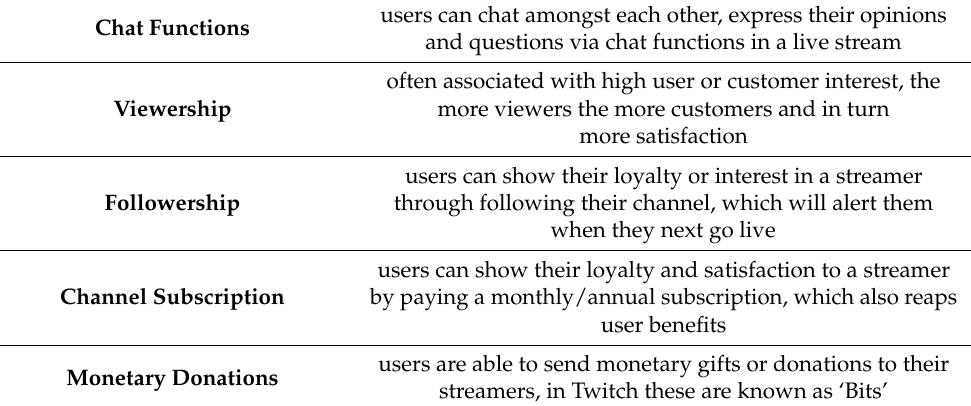
Table 1. Methods in which viewers can be engaged or express their satisfaction in live stream commerce. users can chat amongst each other, express their opinions Chat Functions and questions via chat functions in a live stream often associated with high user or customer interest, the Viewership more viewers the more customers and in turn more satisfaction users can show their loyalty or interest in a streamer Followership through following their channel, which will alert them when they next go live users can show their loyalty and satisfaction to a streamer Channel Subscription by paying a monthly/annual subscription, which also reaps user benefits Monetary